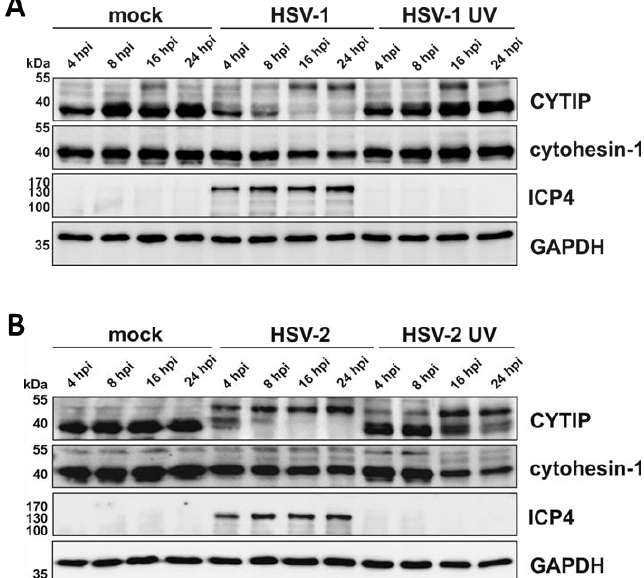
Figure 9. Downmodulation of CYTIP protein levels in HSV-1- and HSV-2-infected mDCs occurs rapidly upon infection. Mature DCs were mock-, ( A ) HSV-1- (MOI of 2), HSV-1 UV- (MOI of 2; 8 × 0.12 J / cm 2 ), ( B ) HSV-2- (MOI of 5), or HSV-2 UV-infected (MOI of 5; 8 × 0.12 J / cm 2 ) and harvested at the indicated time points post infection. Protein lysates were prepared and equal amounts were loaded on a 12% acrylamide SDS-gel, which was subjected to Western blotting. Protein expression of CYTIP, HSV-1 ICP0 / 4 as infection control and GAPDH as loading control were detected. The experiment was performed three times with cells from di ff erent healthy donors and representative data are shown.